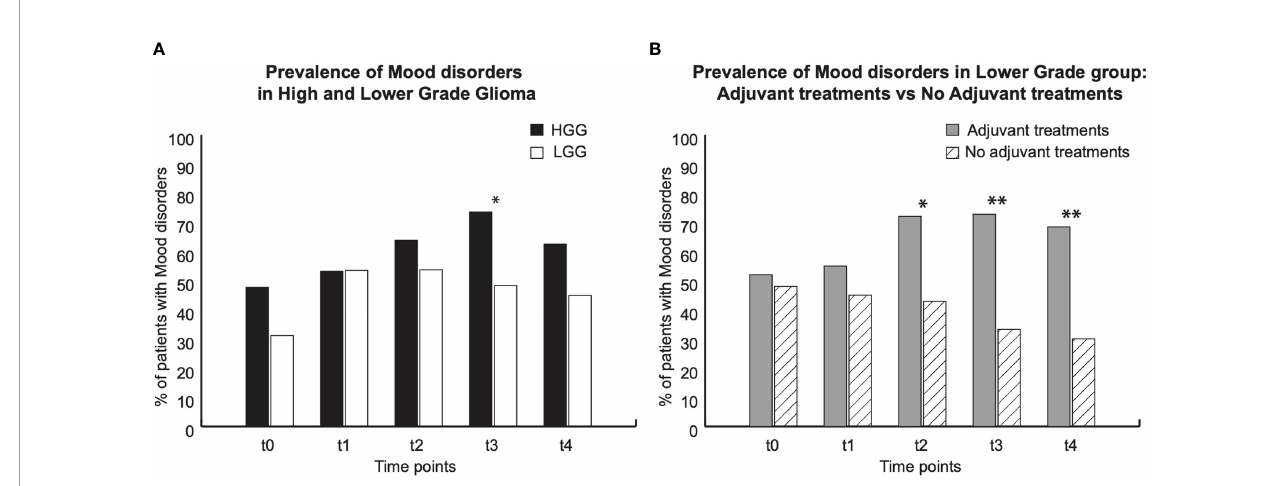
FIGURE 2 | Prevalence of Mood disorders (HADS score). For each group, graphs show data at each time point: t0 (pre surgery); t1 (1 month after surgery); t2, t3 and t4 (respectively 3, 6 and 12 months after surgery). (A) Prevalence of MD in High grade Glioma (HGG) (Black bars, and in lower grade glioma (white bars). (B) Prevalence of MD in lower grade group: gray bars patients underwent to adjuvant treatments, white dashed bars patients who did not undergo adjuvant treatments. * indicate p < 0,05; ** p < 0,01.